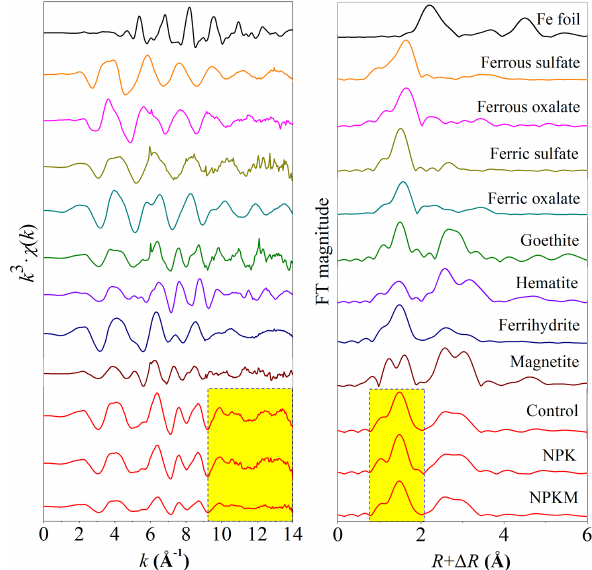
Figure 5. Fe K-edge EXAFS (left) and Fourier transforms (right) of reference materials and soil colloids from three contrasting long- term (1990–2014) fertilization treatments. Control, no fertilization; NPK, chemical nitrogen, phosphorus, and potassium fertilization; NPKM, chemical NPK plus swine manure